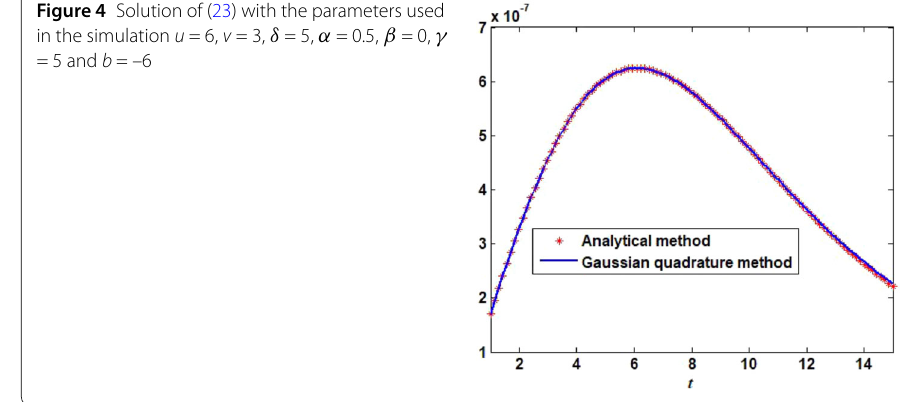
Figure 5 Solution of (24) with the parameters used in the simulation u = 6, v = 3, δ = 10, α = 0.5, γ = 12 and b =